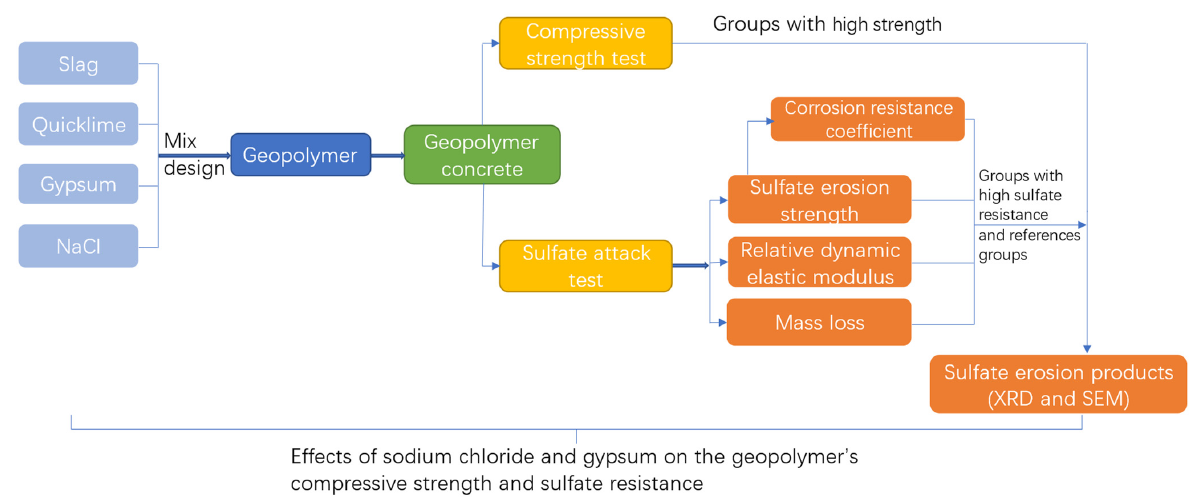
Figure 3. Flowchart of the research.